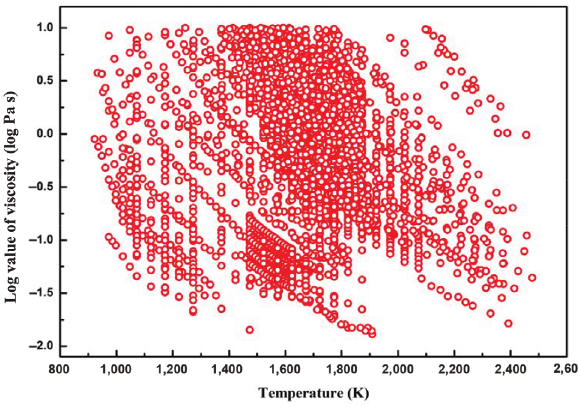
Figure 1: Viscosity – temperature relationship of molten slags in the